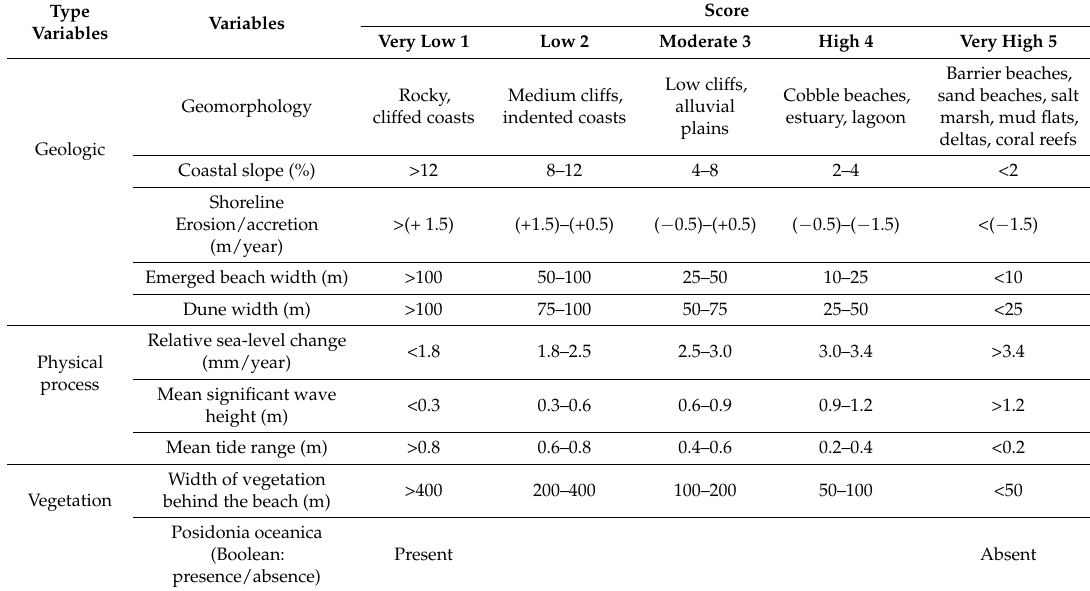
Table 1. Ranges of vulnerability for the considered variables.